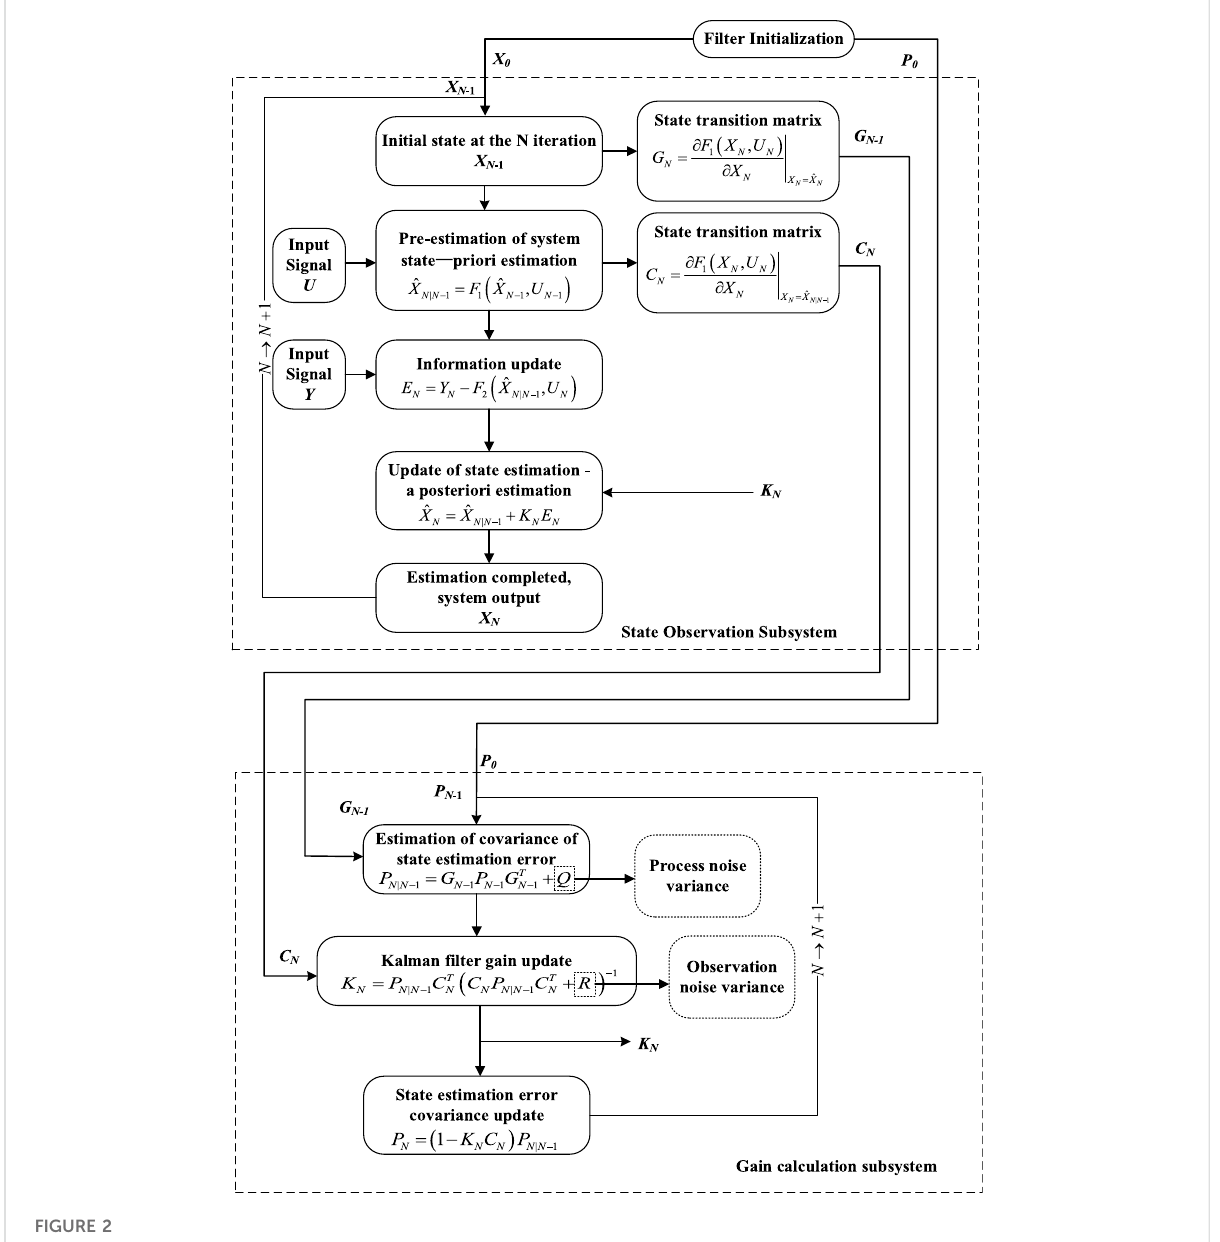
FIGURE 2 SOC calculation process based on